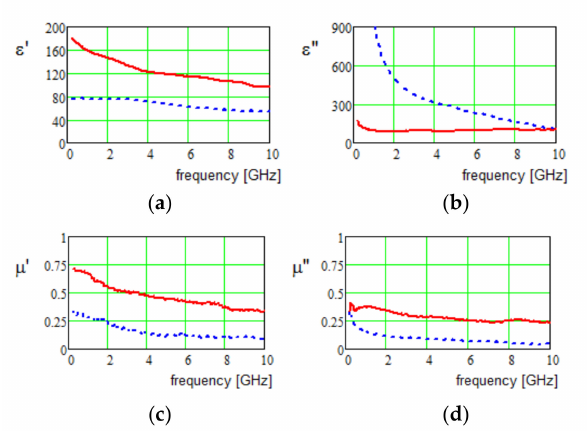
Figure 3. ( a , b ) permittivity of graphite (blue, dashed lines) and reduced graphene oxide (red, solid lines); ( c , d ) permeability of graphite (blue, dashed lines) and reduced graphene oxide (red, solid